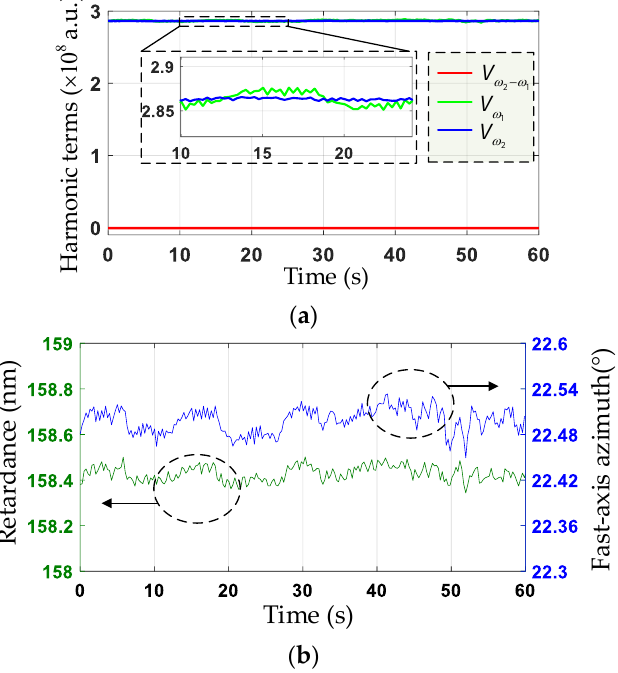
Figure 4. The 1/4 waveplate parameter experimental results: ( a ) harmonic terms; ( b ) waveplate parameter measurement values. parameter measurement values.